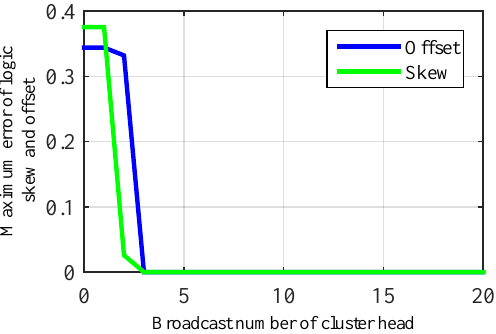
Figure 4. Illustration of convergence speed of logic clock skew and offset by using CMTS in intra-cluster time synchronization.